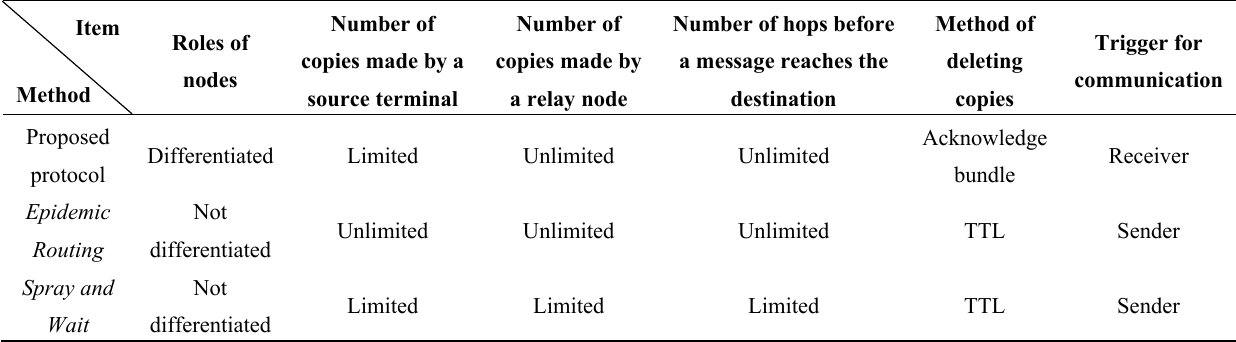
Table 2. Technical differences between the proposed protocol and the existing routing